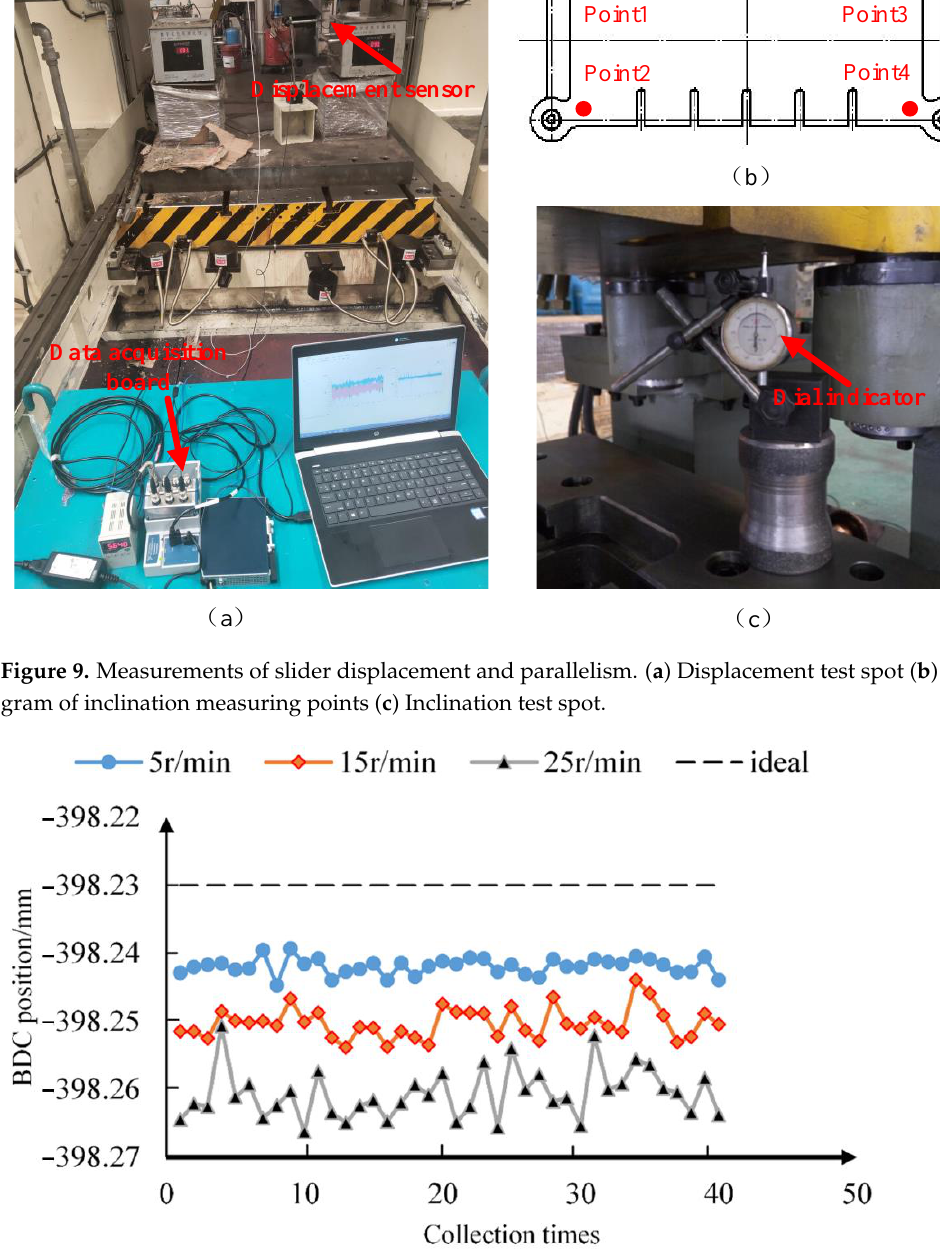
Table 6. Parallelism values of each measuring